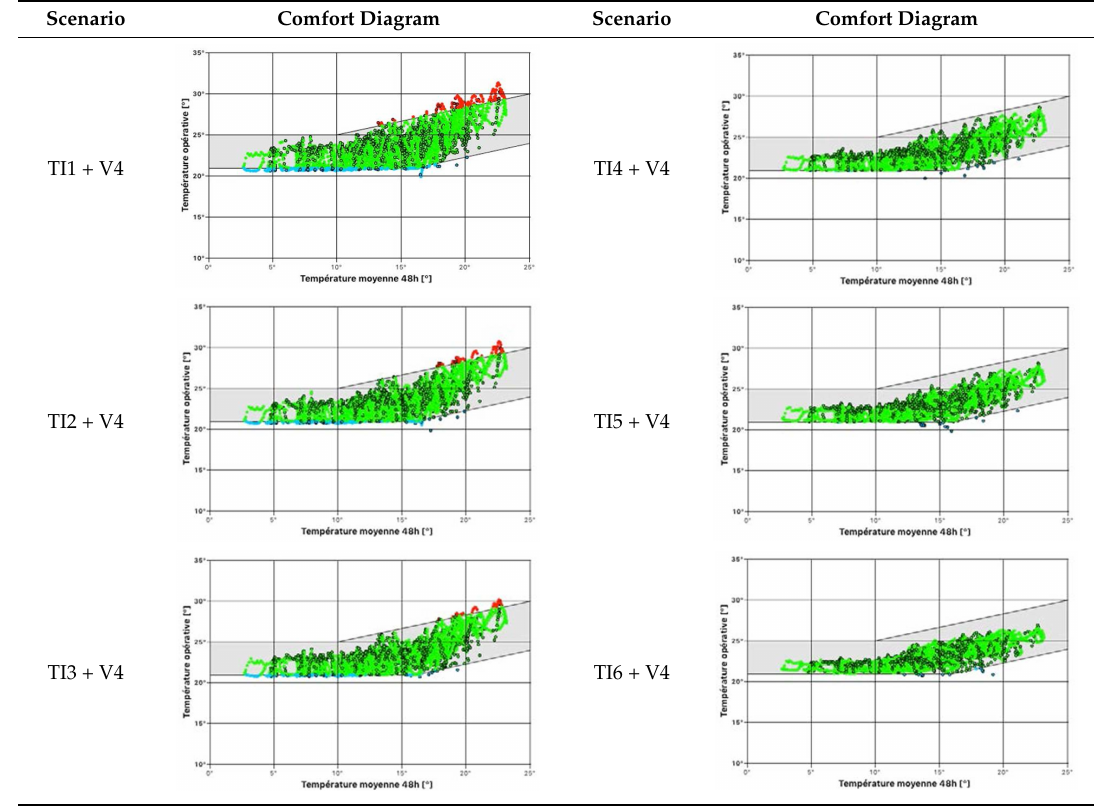
Table 6. Adaptive comfort diagram with indication of discomfort